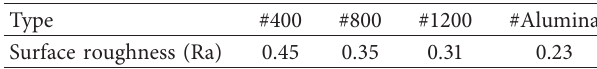
Table 4: Surface roughness value